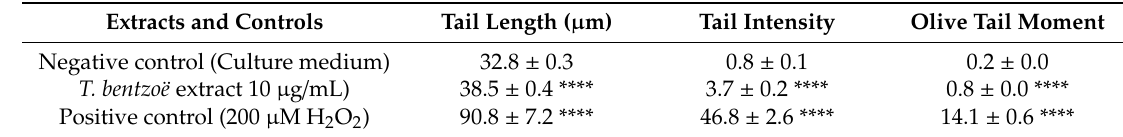
Table 4. Tail length, tail intensity and olive tail moment of H 2 O 2 and T. bentzoë treated HepG2 cells. Extracts and